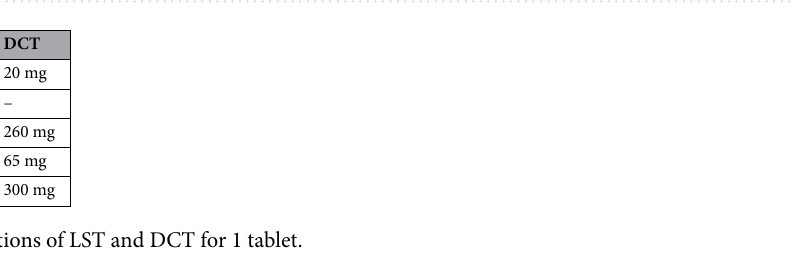
Figure 1. Schematic representation of the formulation of hybrid LS powder 30 .